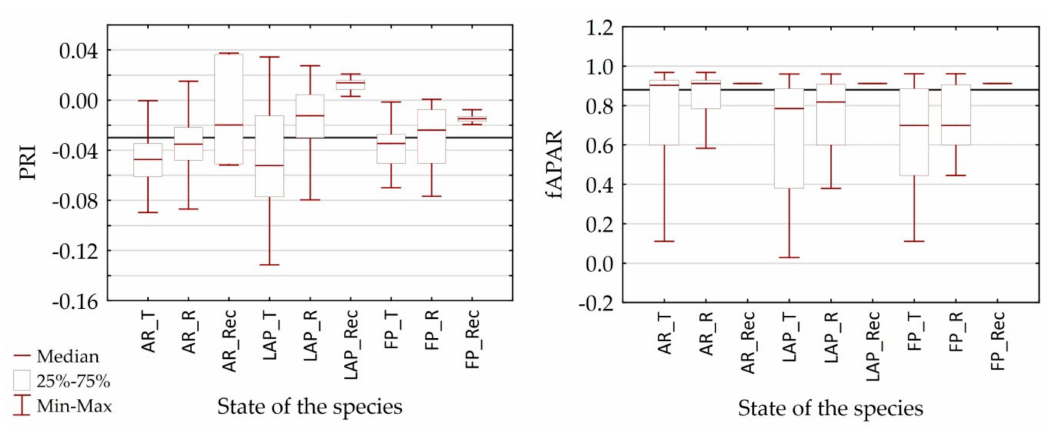
Figure 8. Values of indices: PRI (Photochemical Reflectance Index), fAPAR (fraction of Absorbed Photosynthetically Active Radiation), n = 49,375 per species.